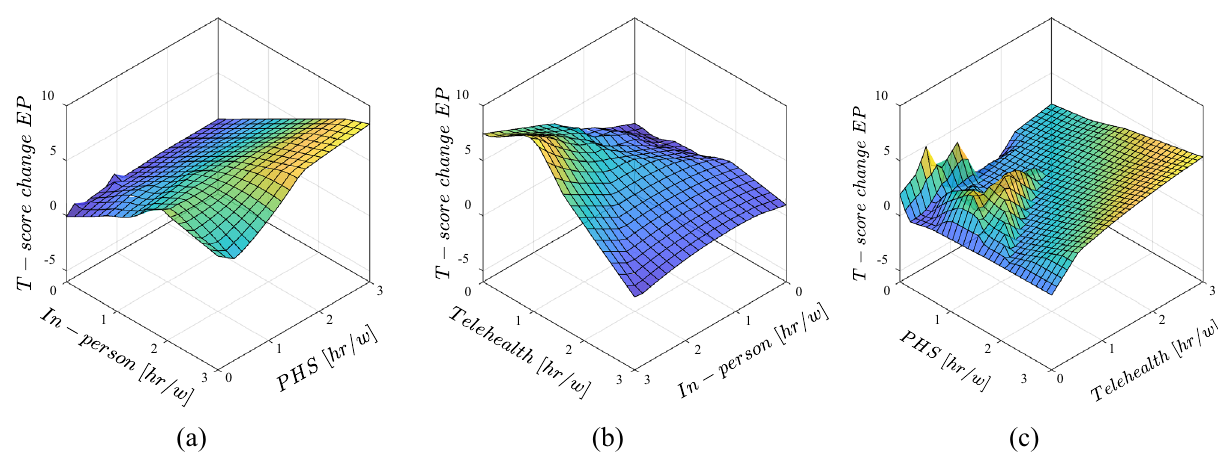
Figure 6. Effects of different speech therapy approaches on the change in externalizing problems in comparison data from pre- and post-lockdown, ( a ) effect of concurrent in-person and PHS treatments, ( b ) effect of concurrent telehealth and in-person treatments, ( c ) effect of concurrent PHS and telehealth